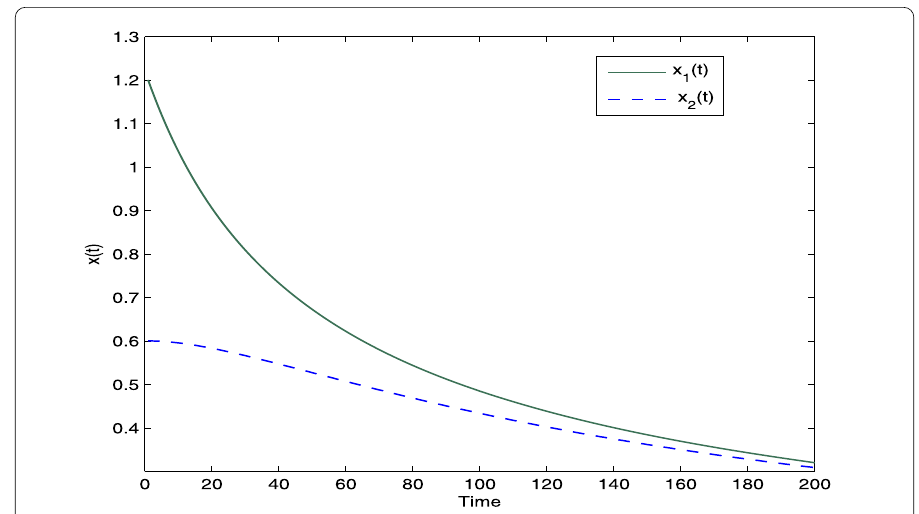
Figure 1 The simulation results of the actual decay rate with the initial condition x (0) = [1.2,0.6] T and the MDT τ =